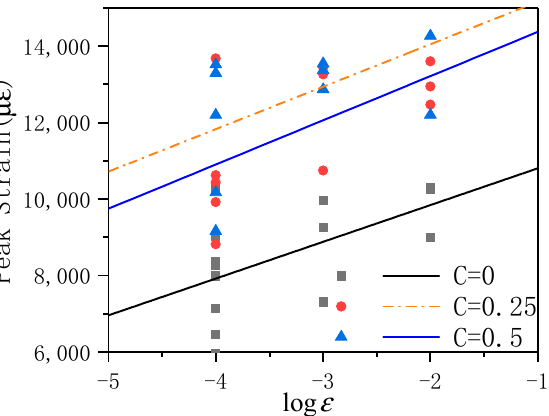
time, when the strain rate is constant, with the increase of lateral pressure, the average ultimate peak strain of ECC is also increasing. Regarding the increase of ECC peak stress, Yin believes that the effect of adding fibers to concrete is equivalent to providing some small constraints on the free surface [25]. At the same time, due to the introduction of lateral pressure, under the combined action of these two factors, in the process of fiber being pulled out and broken, it is equivalent to the formation of a triaxial compression environment, so that the peak stress of ECC has been significantly improved.